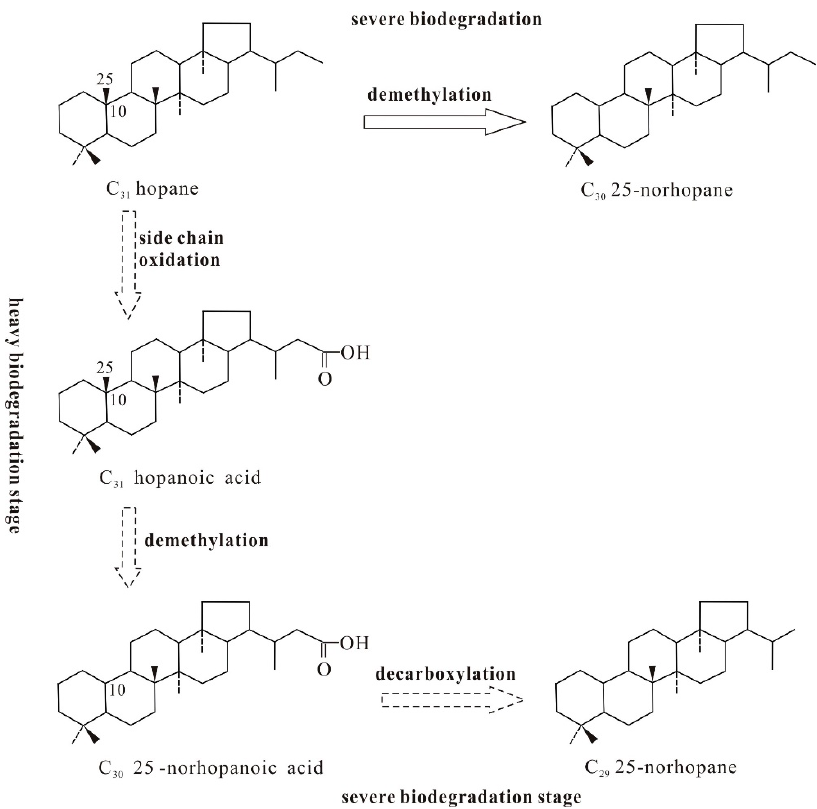
Figure 5. Putative biodegradation pathways of hopanes (taking C 31 hopane as an example).